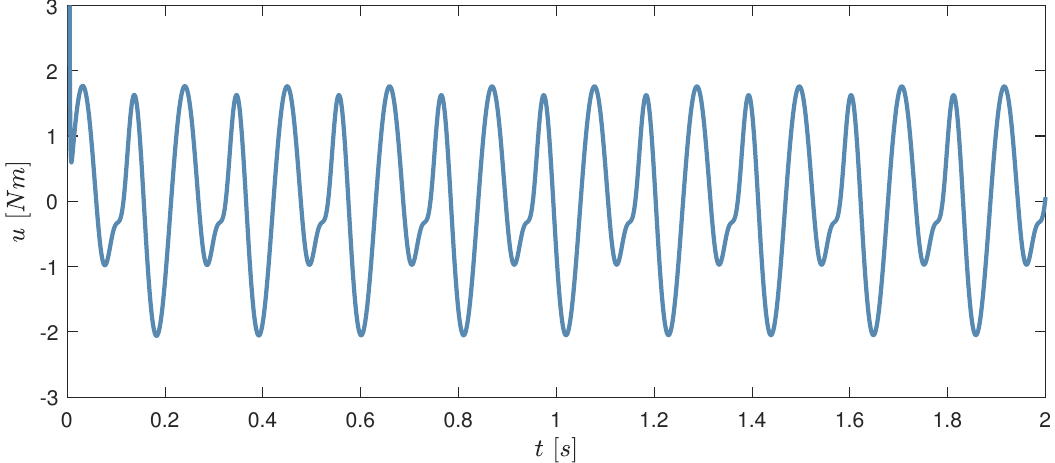
Figure 15. Computed driving torque generated by the tuned control algorithm for the case of Figure